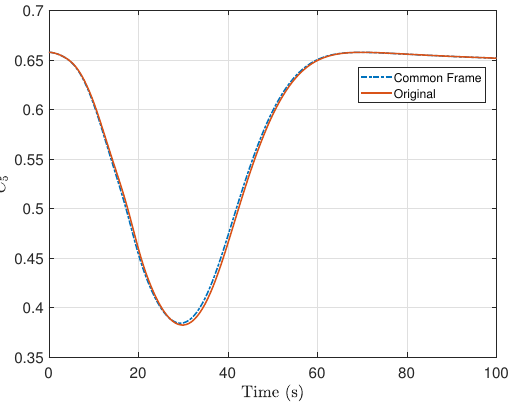
Figure 11. Comparison of Equation (34) in the Common Frame and the Original representation.